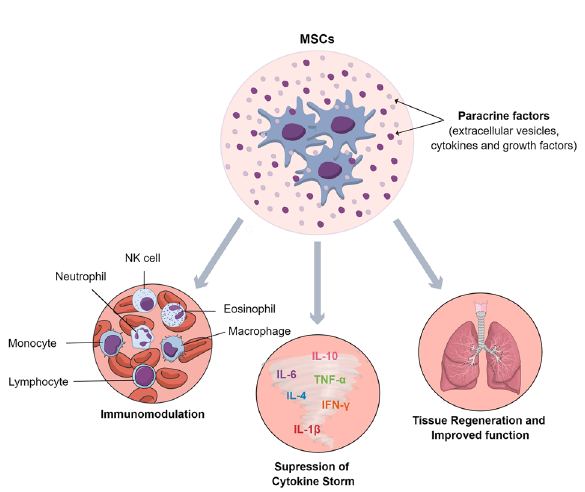
Fig. 1 Potential mechanisms by which mesenchymal stem cells (MSCs) can improve outcomes in COVID-19 patients. MSCs can directly modulate a variety of immune cells from their proin fl am- matory states into non-in fl ammatory or anti-in fl ammatory pheno- types, suppress cytokine storm, and promote lung